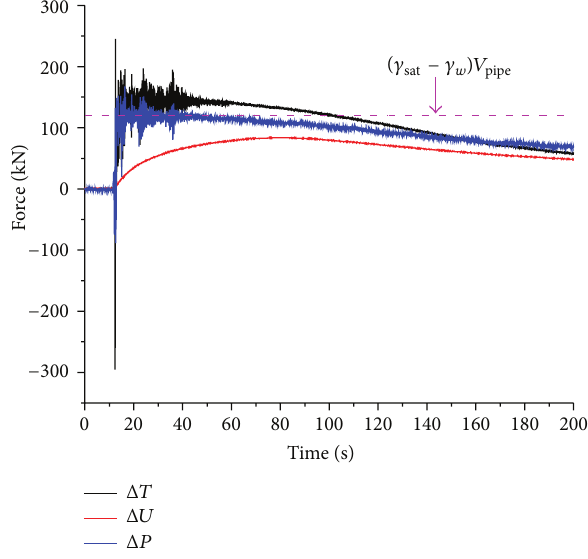
Figure 13: Schematic diagram of force of pipe 2# during shaking.